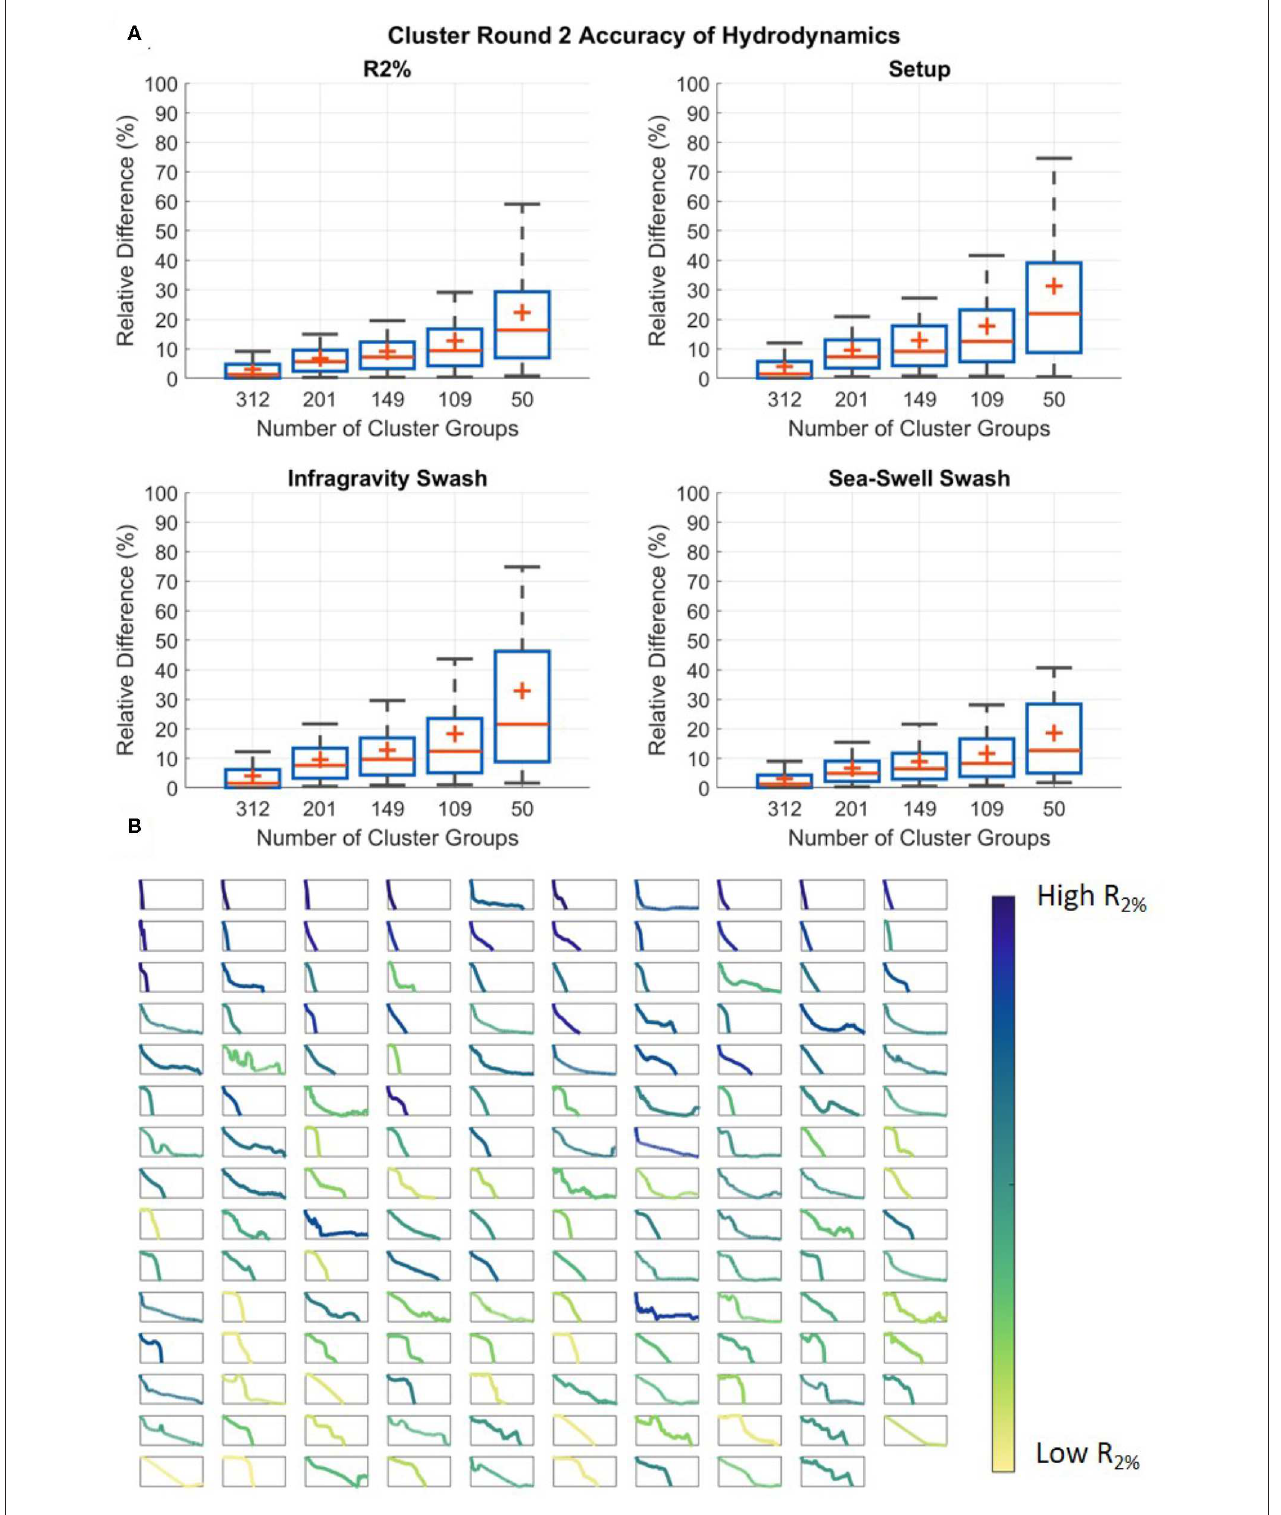
FIGURE 8 | (A) The similarity of the R 2 % (top left), setup at the shoreline (top right), infragravity (bottom left), and sea-swell swash (bottom right) of the grouped initial representative cluster profiles (iRCPs) from the hierarchical cluster analysis (Step 3). The x-axis contains the number of representative cluster profiles (RCPs), and